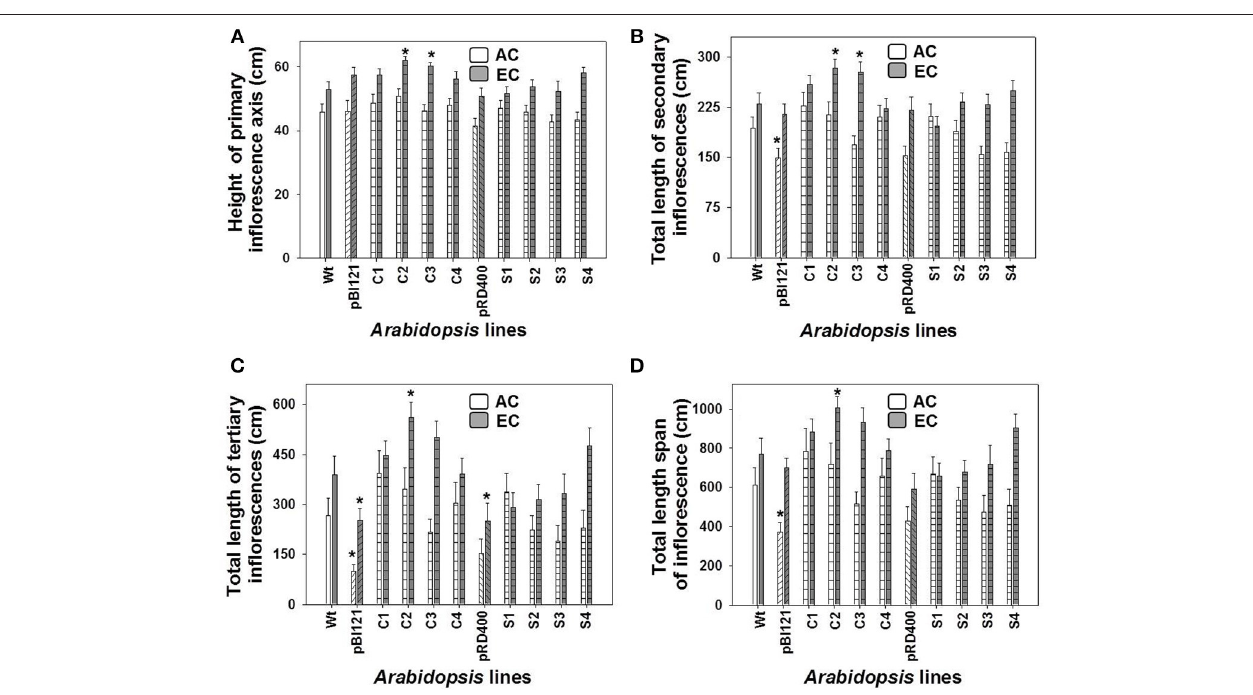
FIGURE 4 | The lengths of 1 ◦ , 2 ◦ , and 3 ◦ inflorescences and the total inflorescence length in Arabidopsis lines grown at either AC or EC. The final height of the 1 ◦ inflorescence axis (A) , and the total lengths of the 2 ◦ (B) , 3 ◦ (C) inflorescences, and the total length span of inflorescence (D) for Arabidopsis lines grown at either AC or EC are presented. CO 2 treatments: 380 ppm (AC, white bars), 700 ppm (EC, gray bars). Asterisks ( * ) indicate results significantly different from wild-type (WT) at α = 0.05. Values represent the mean ± SE; n = 10 plants per line. Representative plants for each CO 2 treatment are shown in Supplementary Figure 4.